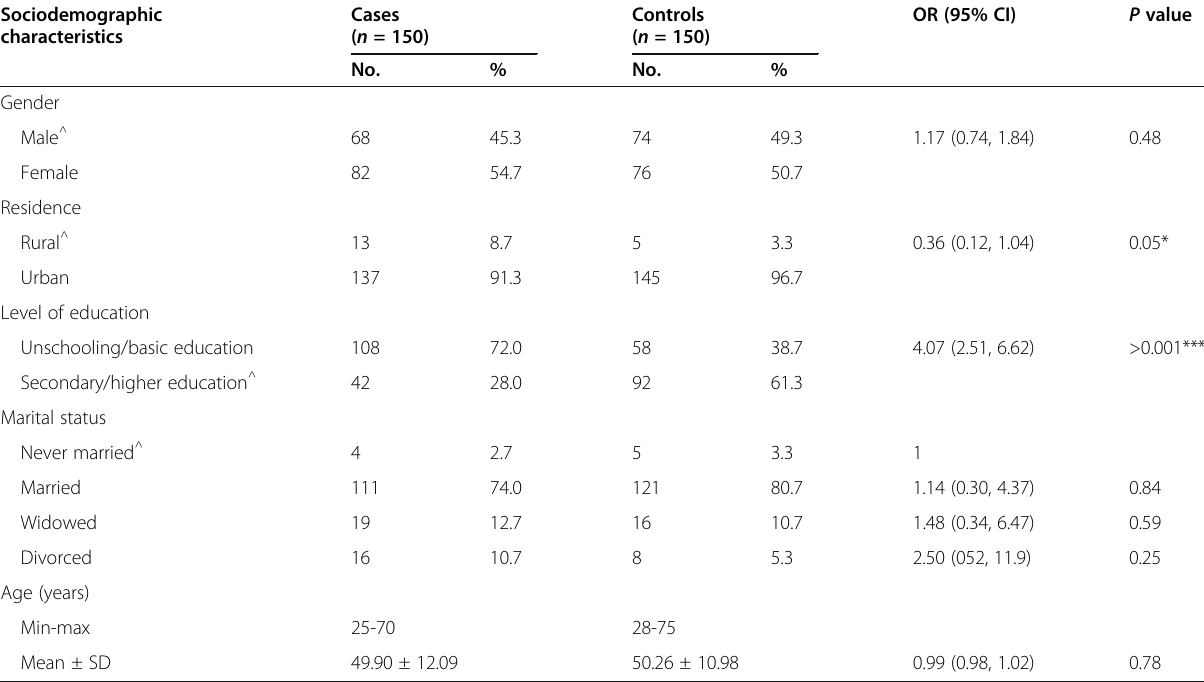
Table 1 Sociodemographic characteristics of studied patients attending the vascular surgery and ophthalmology outpatient clinics at the Alexandria Main University Hospital, 2019, Egypt Sociodemographic